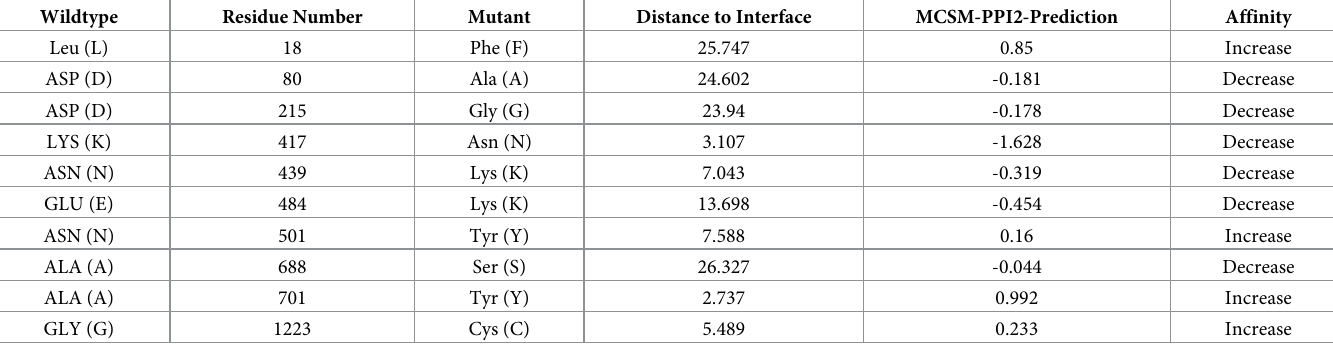
Table 2. The predicted effect of missense mutations in the spike protein of Pahang SARS-CoV-2 D614G variants. Wildtype